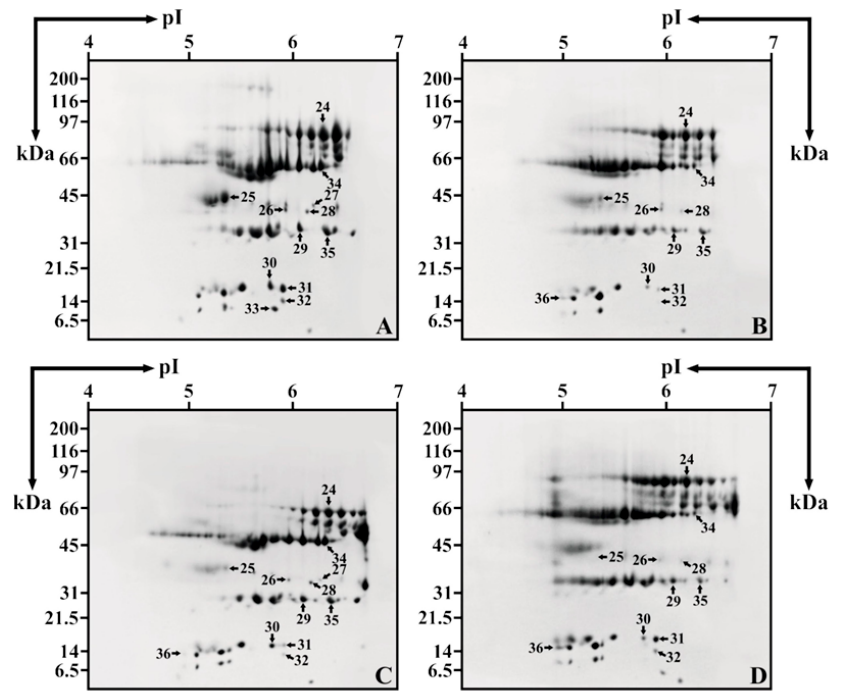
Figure 7. 2D-PAGE separations of the vicilin fraction (( A )—cv. Nadwi ś la ń ski seeds stored at − 14 °C; ( B )—cv. Nadwi ś la ń ski seeds after +20 °C storage; ( C )—cv. Dino seeds stored at − 14 °C; ( D )—cv. Dino seeds stored at +20 °C).